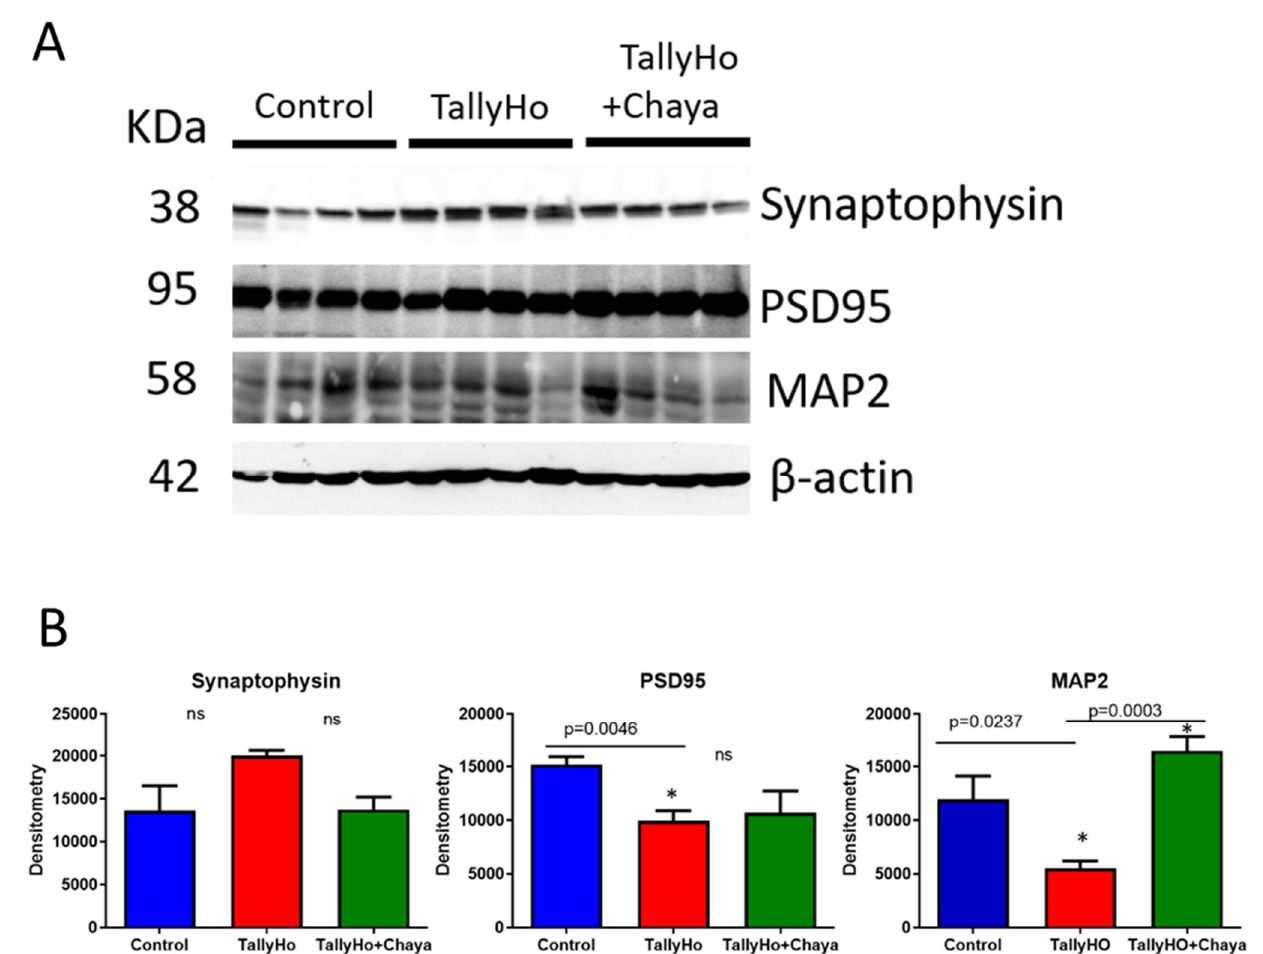
Figure 6. Immunoblotting analysis of mitochondrial synaptic and neuronal proteins using protein lysates obtained from the post-mortem brains of 14-month-old non-diabetic control mice, TH mice fed with chaya, and TH mice fed with regular chow (for each of the three groups, n = 4). ( A ) Immunoblots for the control, TH, and TH + chaya mice. ( B ) Quantitative densitometry analysis for the mitochondrial synaptic proteins synaptophysin, PSD95, and the neuronal protein MAP2. The expression levels of PSD95 and MAP2 were significantly decreased in the TH mice compared to the control mice (PSD95, p = 0.0046 and MAP2, p = 0.0237), but the levels of synaptophysin did not show any significant change in the TH mice compared to the control mice. MAP2 levels were significantly increased in TH + chaya mice at levels comparable to the control mice (MAP2, p = 0.0003). However, PSD95 did not show a significant change in the TH + chaya animals. * p = 0.01.